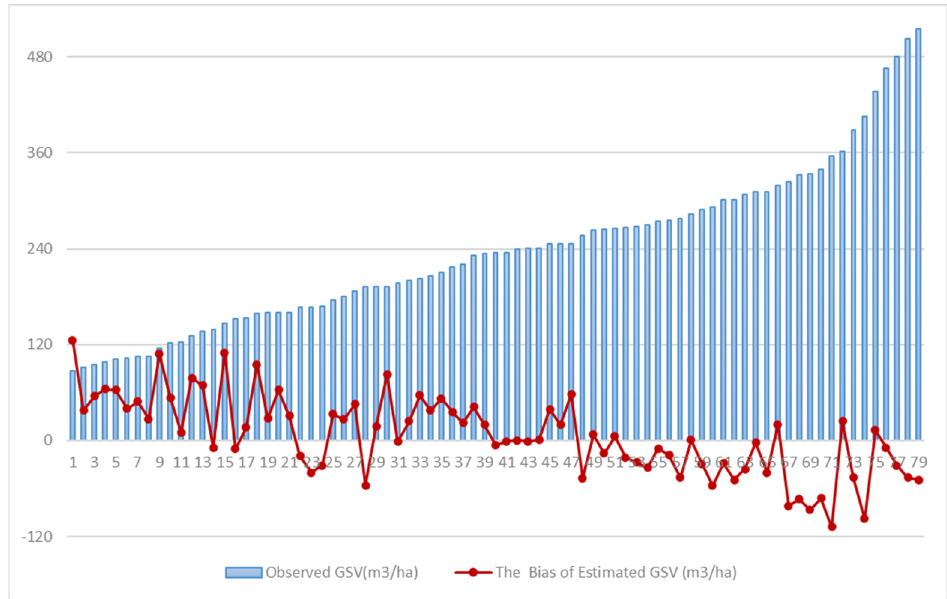
Figure A3. The residuals analysis of the estimated GSV. The data source used for GSV estimation modeling was the integrated dataset of GF-2 and Sentinel-2 images, and the feature selection method was AFCO-RFR, and the regression algorithm was RFR.